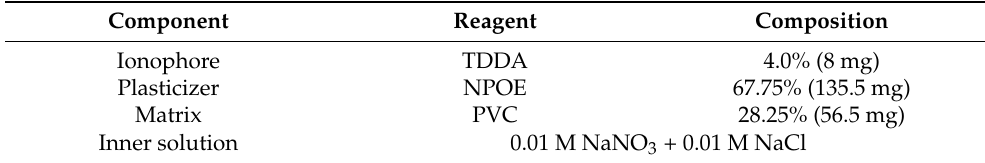
Table 1. Chemical compositions of NO 3 − ISE membranes used in this